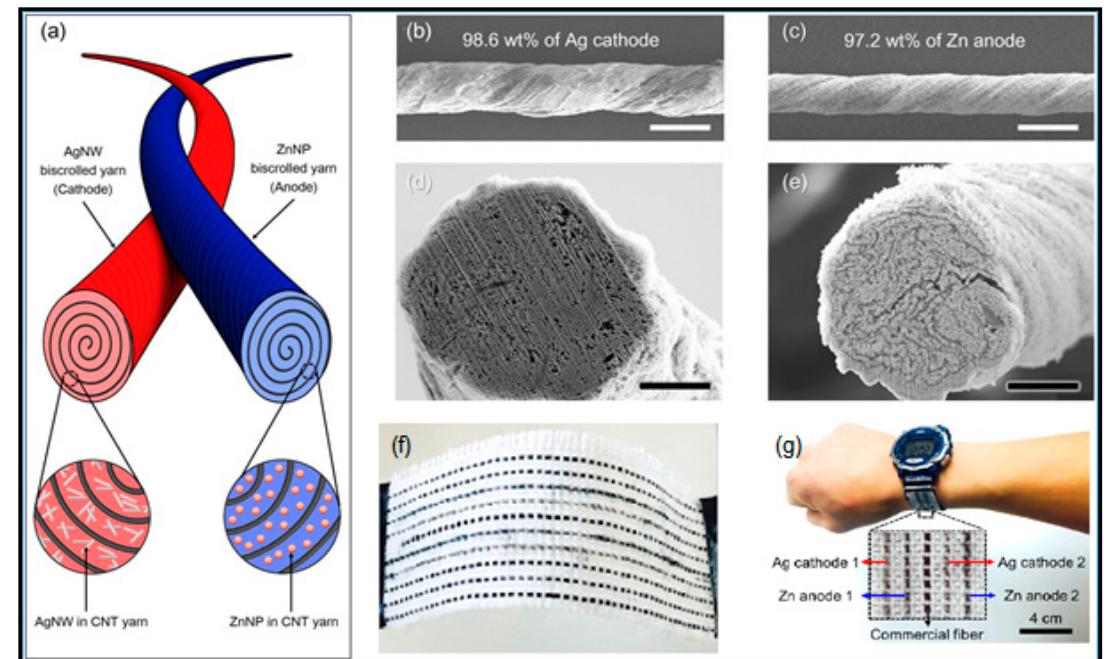
Figure 6. ( a ) Schematic illustration of yarn battery consists of Ag nanowire/CNT and Zn nanoparticle/CNT electrodes. SEM images showing ( b ) the Ag yarn electrode (scale bar = 300 µm), ( c ) the Zn yarn electrode (scale bar = 300 µm), ( d ) the cross-section of the Ag electrode (scale bar = 20 µm), and ( e ) the cross-section of the Zn electrode (scale bar = 20 µm). ( f ) and ( g ) Photographs of watchstrap. Reproduced with permission from [240]. Copyright 2018 Nature.